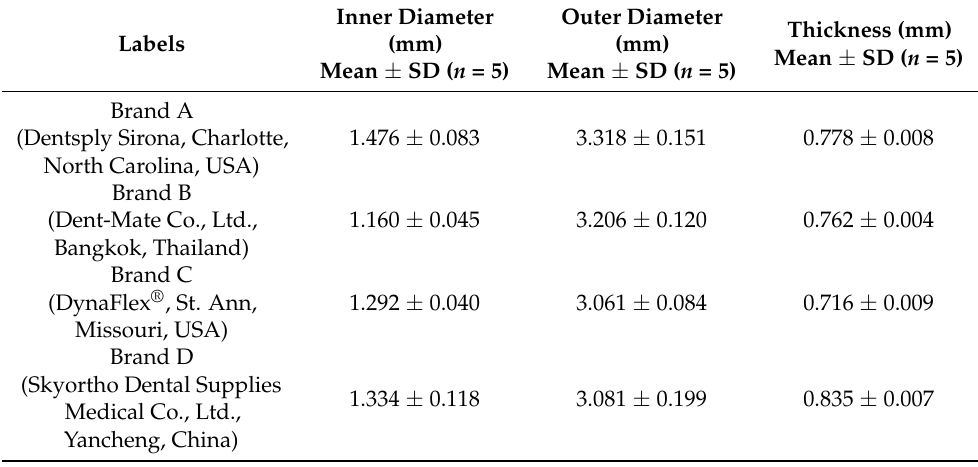
Table 2. Measured geometries of the commercial orthodontic ligature ties used in this study. Inner Diameter Labels